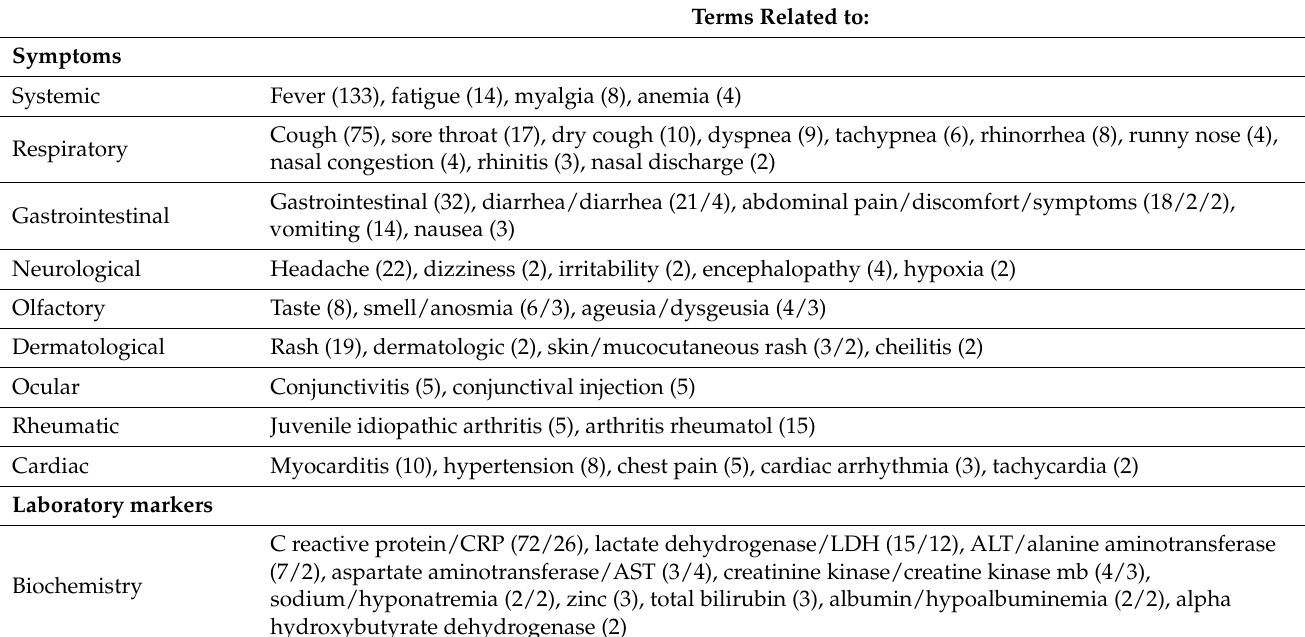
Table 4. Terms/keywords related to the topic of clinical and laboratory characteristics of pediatric COVID-19